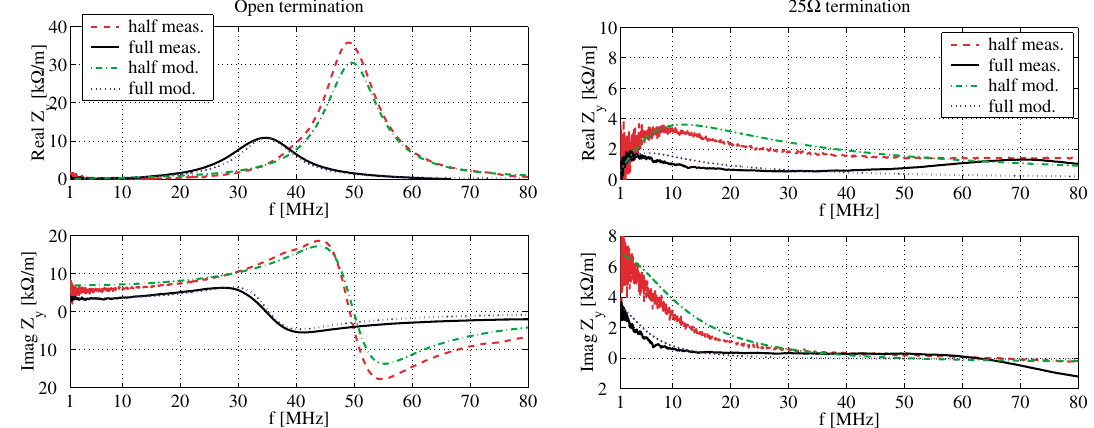
FIG. 8. (Color) Measured (coupled contribution) and predicted impedances for full- and half-size kickers.